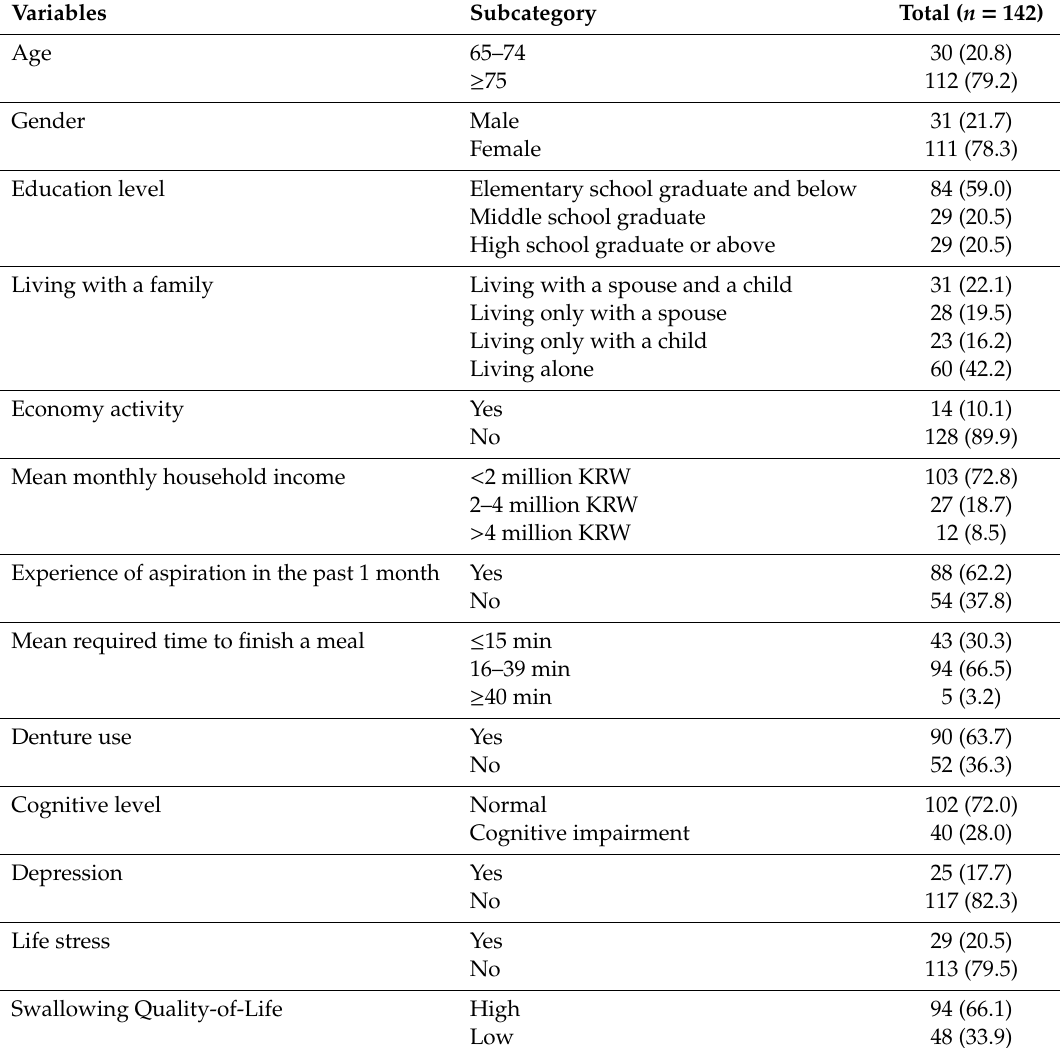
Table 1. General characteristics of subjects, n